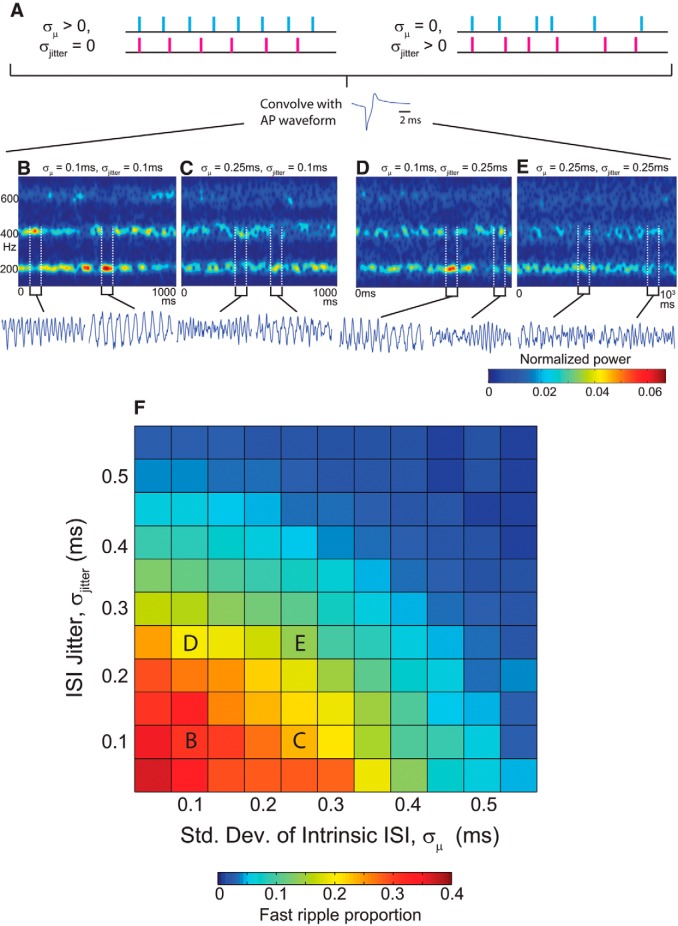
Fast ripple occurrence ratio for constructed LFP’s generated from AP waveforms. A, Constructed LFPs were produced by first generating trains of event times which had two sources of variation: (1) different trains had different values for their intrinsic firing rates, with greater values of σμ implying greater firing rate heterogeneity between different cells, and (2) within each train there was “jitter” in the ISI. These spike trains were then convolved with AP waveforms and summed to yield the constructed LFP. Red and blue spike trains show examples of firing times of two different “cells” with different firing rates (left) or different ISI jitter (right). B–E, Spectrograms and LFP samples from the constructed LFPs generated using the indicated parameters. Fast ripples frequently emerged from random network firing. F, Fast ripple proportion as a function of the two sources of heterogeneity in the model. Fast ripple proportion was simply the proportion of total time that the peak frequency in the 100–700 Hz band was >250 Hz.